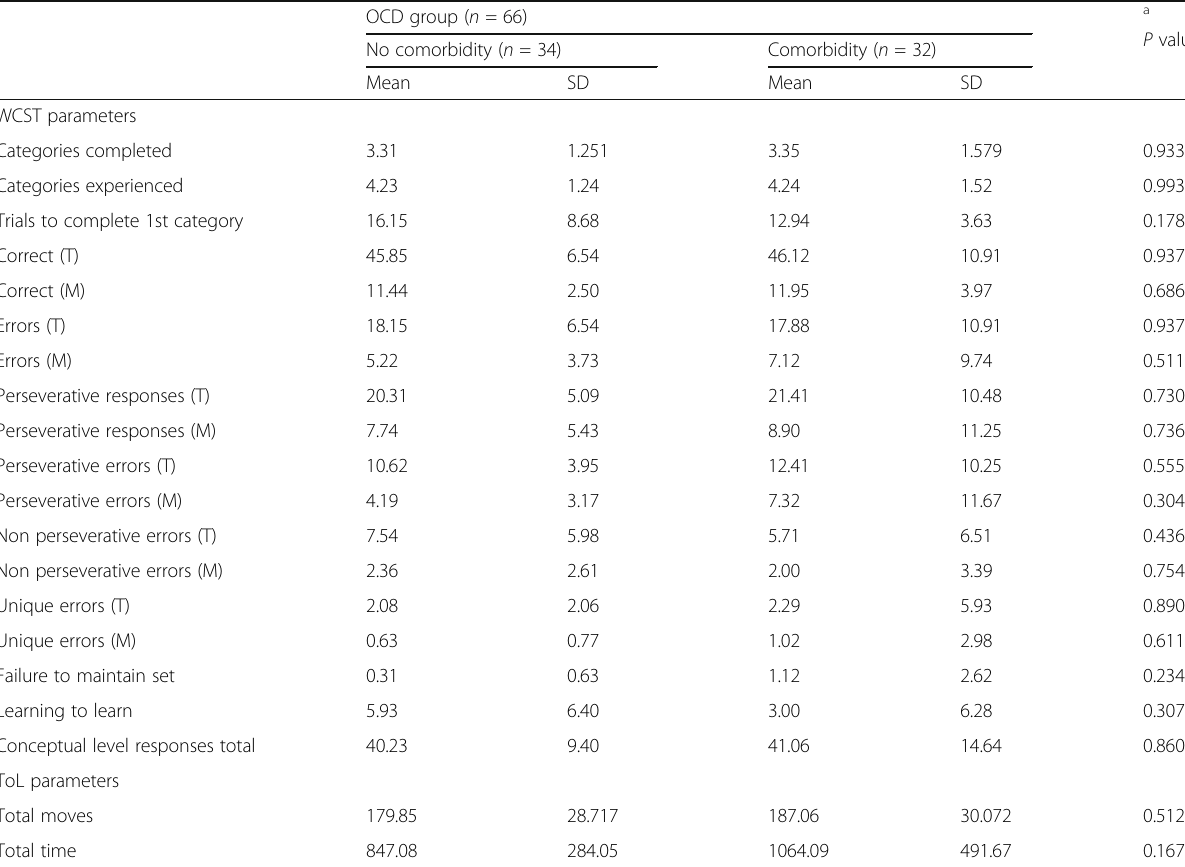
Table 7 Comparison of WCST and ToL parameters regarding comorbidities among OCD group ( n =